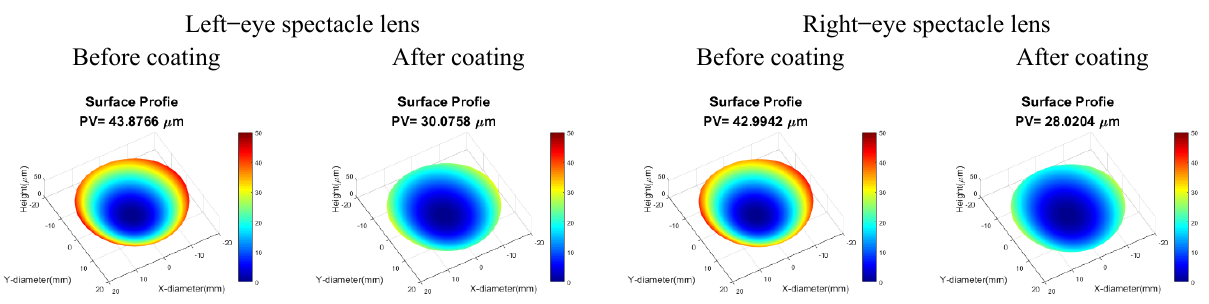
Figure 3. Wavefront contour measurement of the notch filter for the left − and right − eye spectacle lenses.